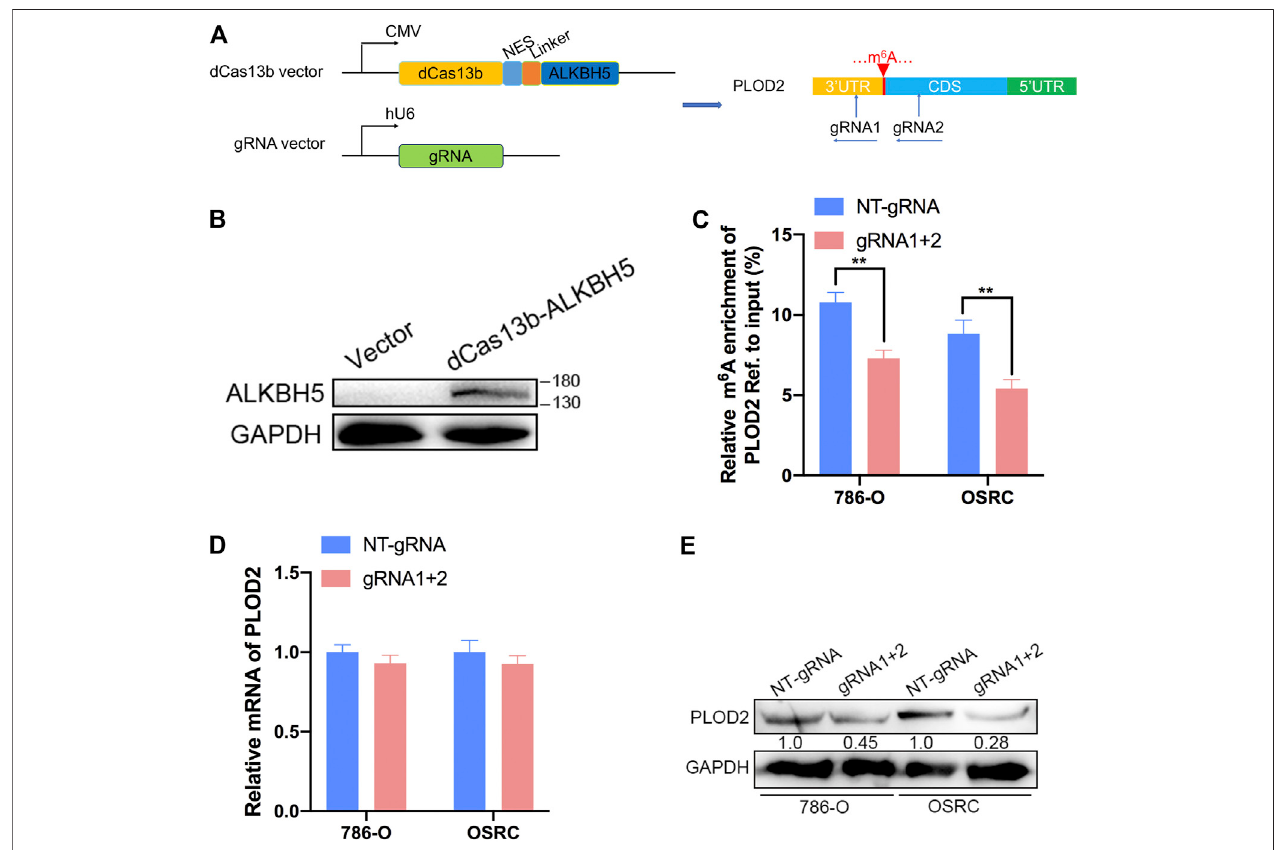
FIGURE 3 | dm 6 ACRISPR induced demethylation of PLOD2 mRNA. (A) Construction of dCas13b-ALKBH5 with two gRNAs targeting methylation region of PLOD2 3 ’ UTR. (B) dCas13b-ALKBH5 fusion protein was examined in cell by western blot. (C) MeRIP-qPCR analysis of PLOD2 mRNA in 786-O and OSRC RCC cells after transfected with dCas13b-ALKBH5 and sgRNAs for 24 h. (D) mRNA expression levels of PLOD2 in 786-O and OSRC RCC cells after transfected with dCas13b- ALKBH5and sgRNAsfor 24 h by RT-qPCR. (E) Protein levels of PLOD2 in 786-O and OSRC RCC cells after transfected with dCas13b-ALKBH5 and sgRNAs for 24 h by western blot. ** p <